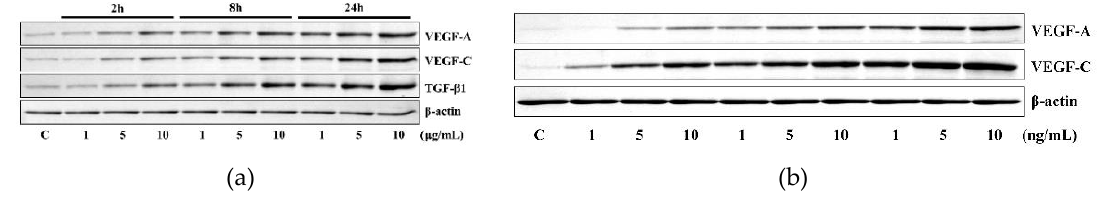
Figure 1. Western blot analysis. ( a ) The application of 4HR increased the expression of VEGF-A, VEGF-C, and TGF-β1. ( b ) The application of TGF-β1 also increased the expression of VEGF-A and VEGF-C. Full-length gels and blots are included in Figures S1 and S2.